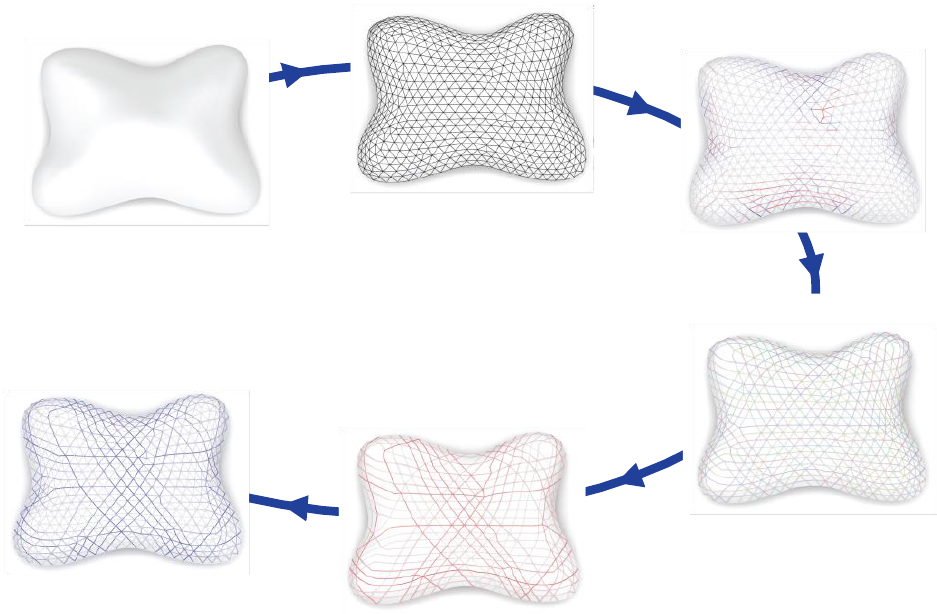
Fig. 4 Morphogenesis pipeline: (a) input geometry; (b) regular re-meshing of the input surface; (c) SLS stress on the linear truss model subject to an external load (red compression, blue tension); (d) set of candidate cable paths; (e) selection of cable paths with accompanying pre-loads; (f) resulting stress on the truss model after the optimization employing selected cables and